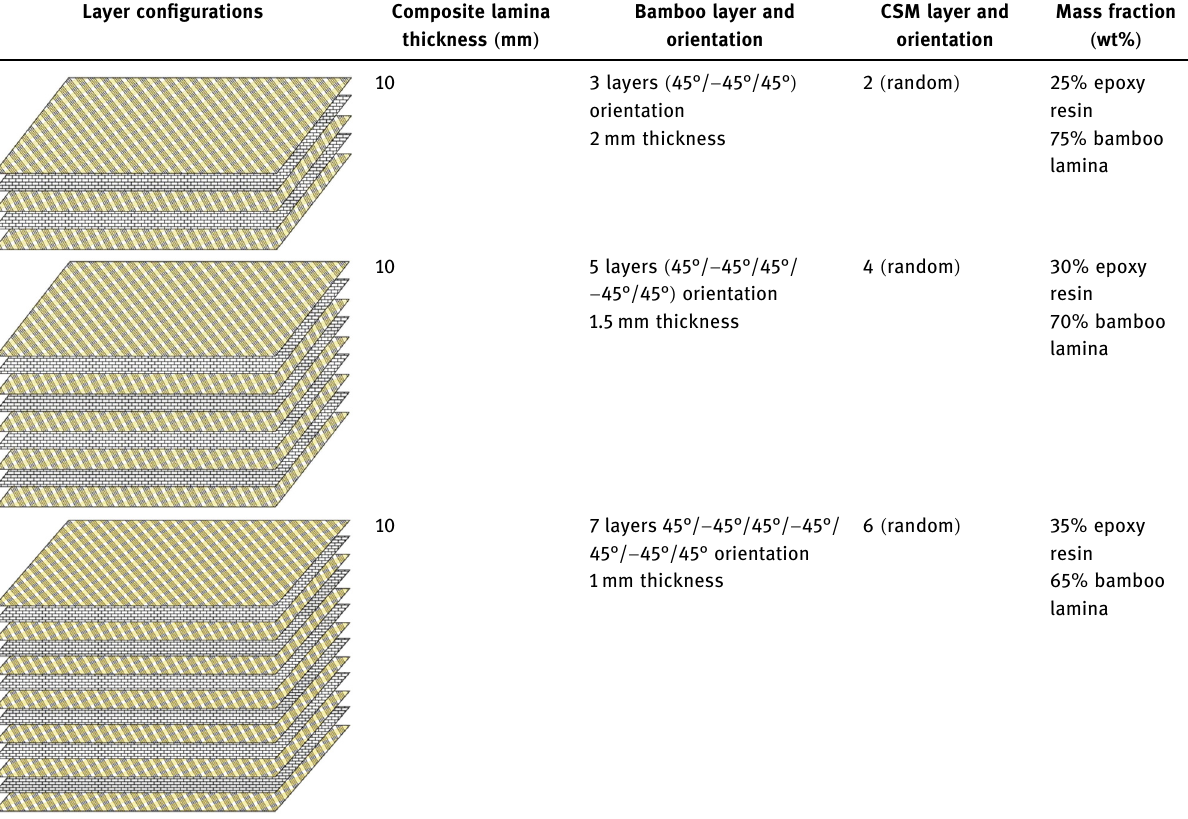
Table 5: Layer con fi guration of LBC Layer con fi